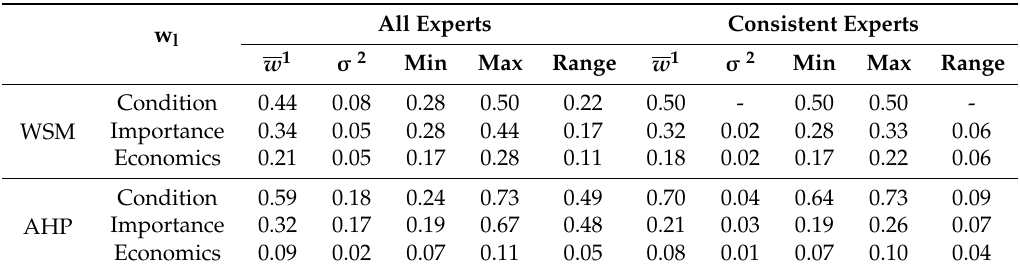
Table 4. Comparison of the weights w l of all and the consistent experts for the sewer network for WSM and AHP. All Experts Consistent Experts w l w